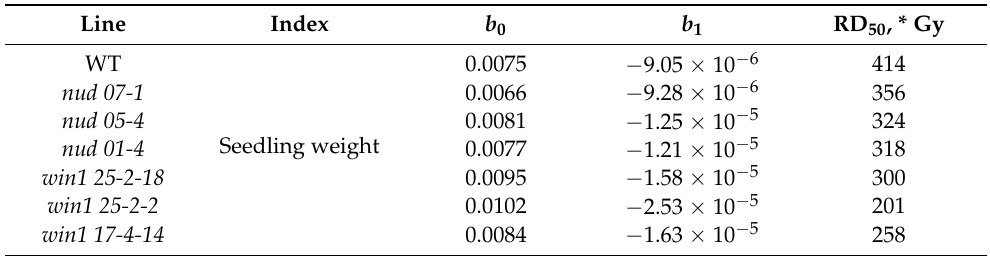
Figure 4. Weights of aboveground and underground parts of barley seedlings of KO lines after irradiation. The number of samples for each dose or line was N = 3. Table 2. Sensitivity of the seven barley lines to γ -radiation (linear regression coefficients b 0 and b 1 are